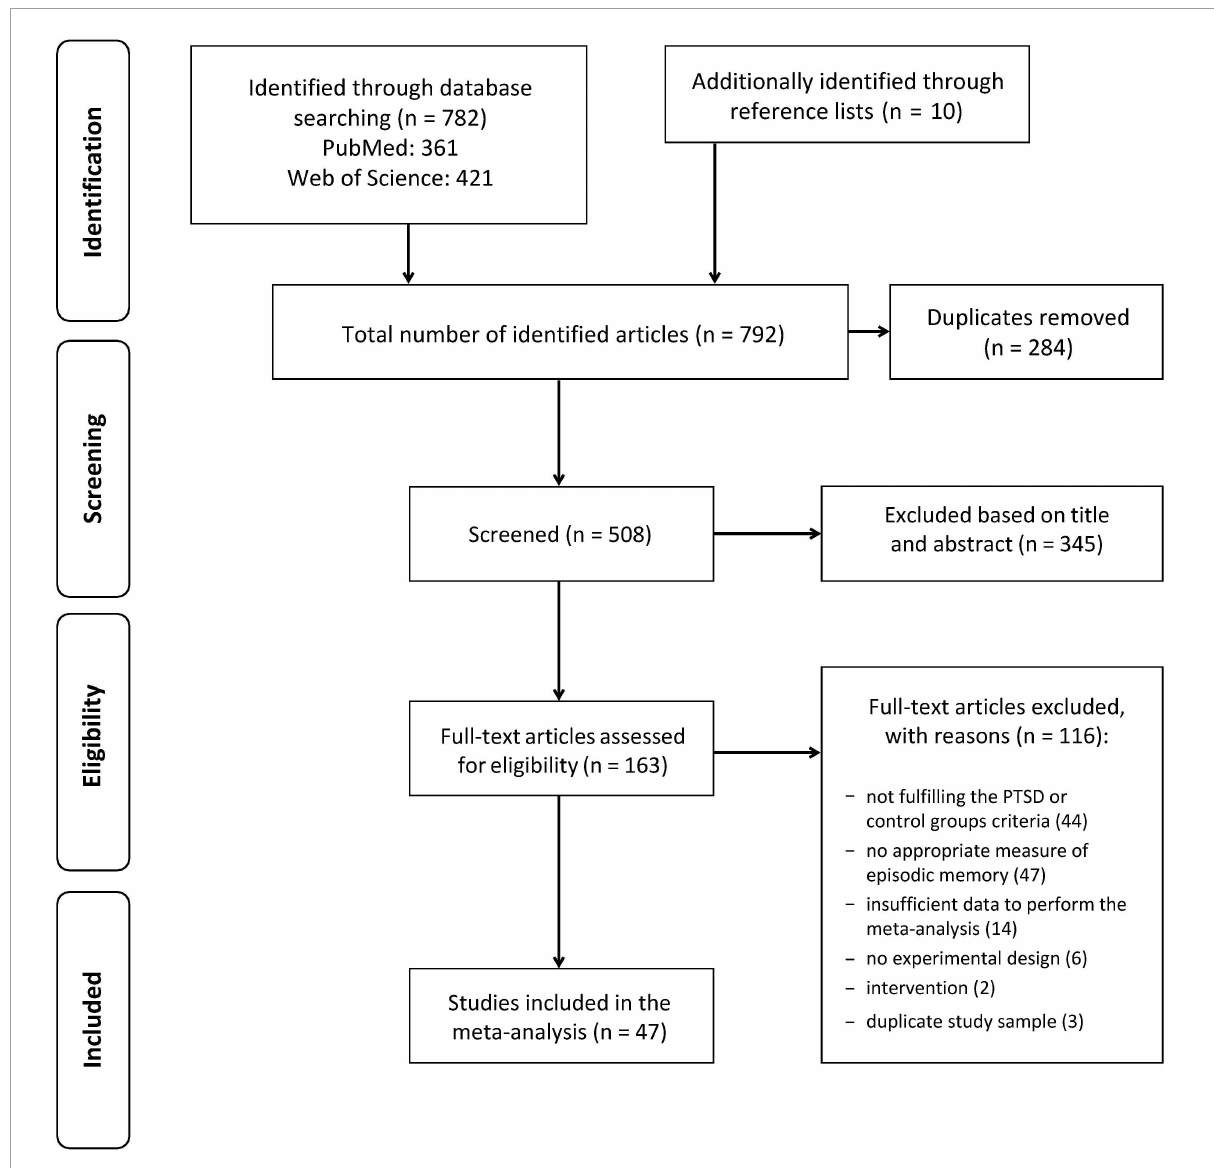
FIGURE1 Flow chart of literature search and selection process.